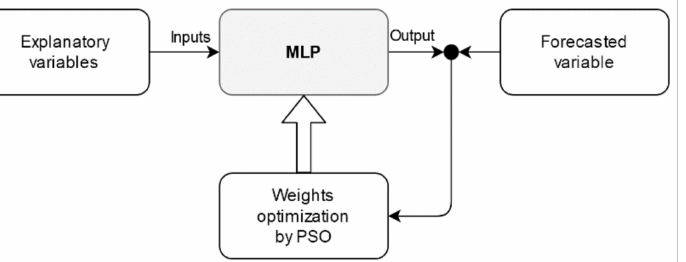
Figure 7. General concept of using particle swarm optimization (PSO) algorithm for multi-layer perceptron (MLP)